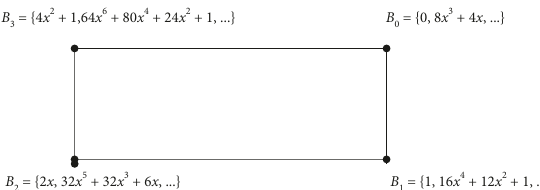
Figure 4: On tetragon representing Pell polynomials which are kept clockwise at its vertices.